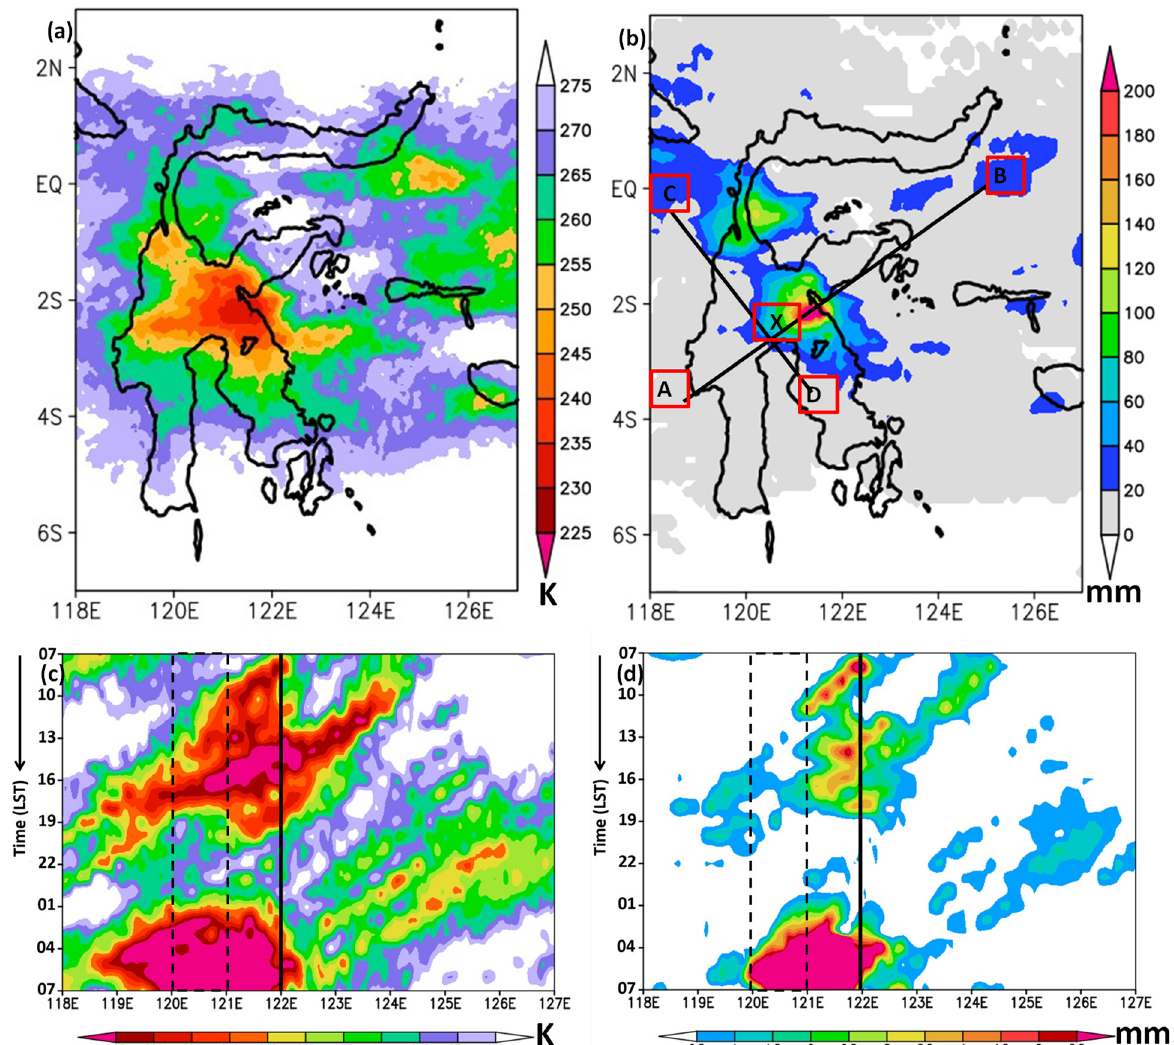
Figure 4. ( a ) A spatial map of the daily average of black body temperature (TBB) cloud-top height from the Himawari satellite over 13–14 July 2020. ( b ) Same as ( a ), but for the daily accumulation of precipitation from the GSMaP satellite. The A–B and C–D transects were used in further analyses in Figures S7 and 8, with the location of the points: A (3.5° S, 118.5° E); B (Eq, 126° E); X (2.5° S, 121° E); C (0.5° S, 118° E); D (4° S, 122° E). The ‘X’ indicates the location of Luwu. ( c ) Time-longitude Hovmöller diagram of TBB cloud-top height averaged over 2° S–3° S (i.e., the Luwu region) from 13 to 14 July 2020 using Himawari satellite data. ( d ) Same as ( c ), but for diurnal precipitation using GSMaP satellite data. The black dashed box indicates the Luwu region (120° E–121° E). The vertical solid line represents the east coast.